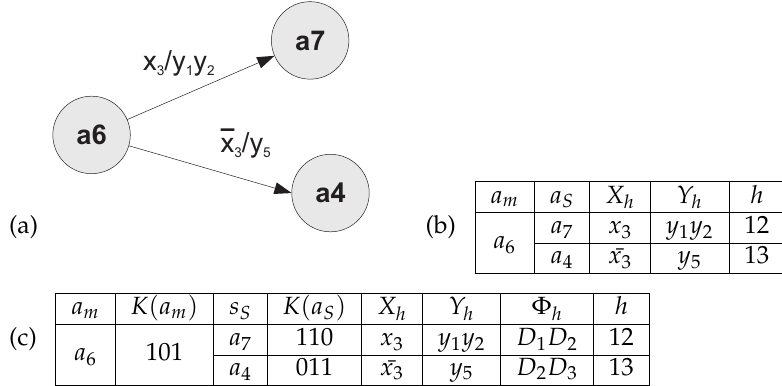
Figure 2. Equivalent fragments of STG ( a ), STT ( b ) and DST ( c